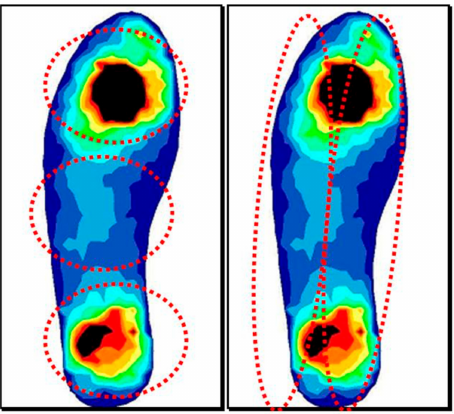
Figure 2. Regions of interest analyzed. Rear, mid, and forefoot. Inner and outer